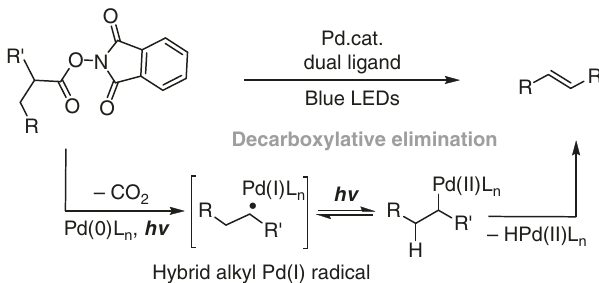
Fig. 1 Working hypothesis. Decarboxylative desaturation via a hybrid alkyl Pd(I) intermediate under